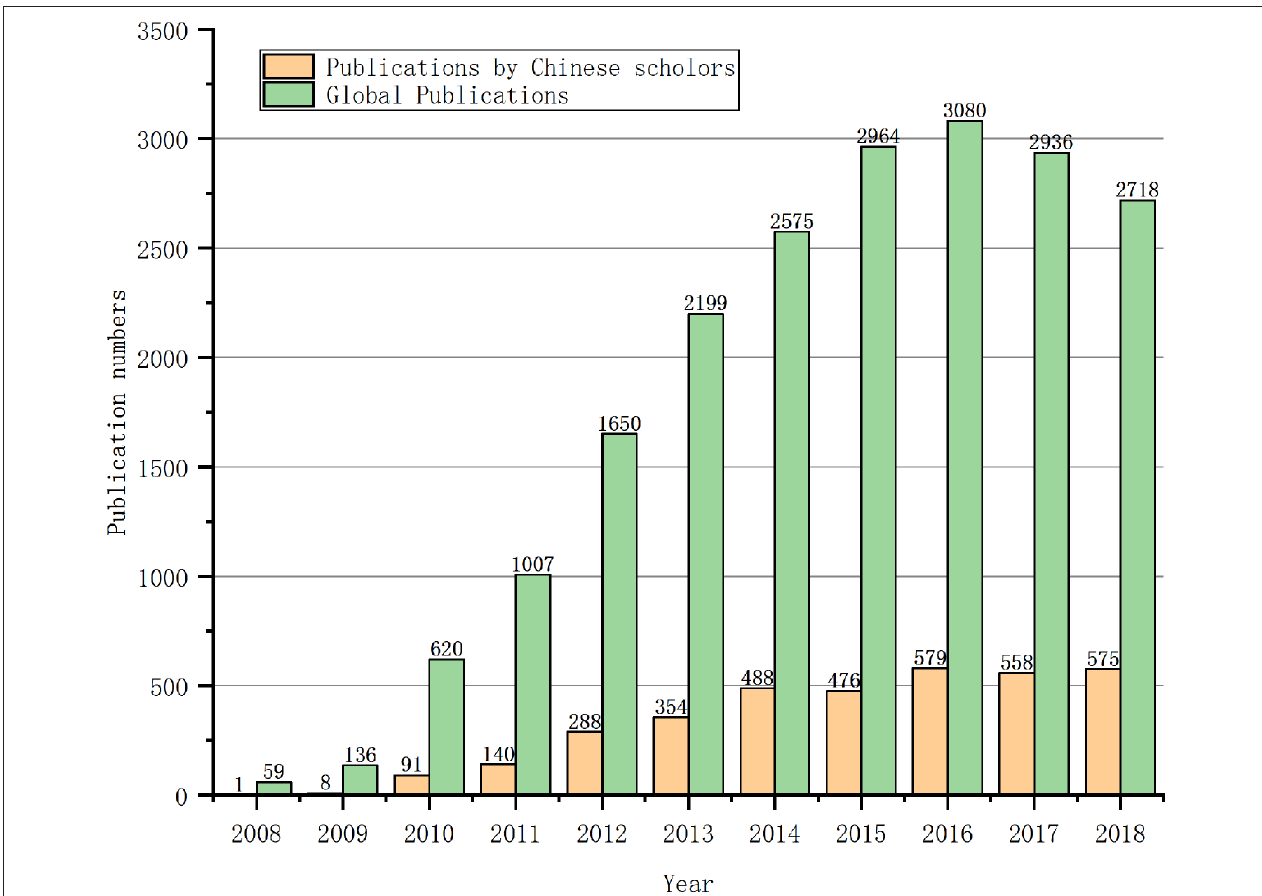
FIGURE 2 | Annual publications by Chinese scholars and worldwide scholars in the field of